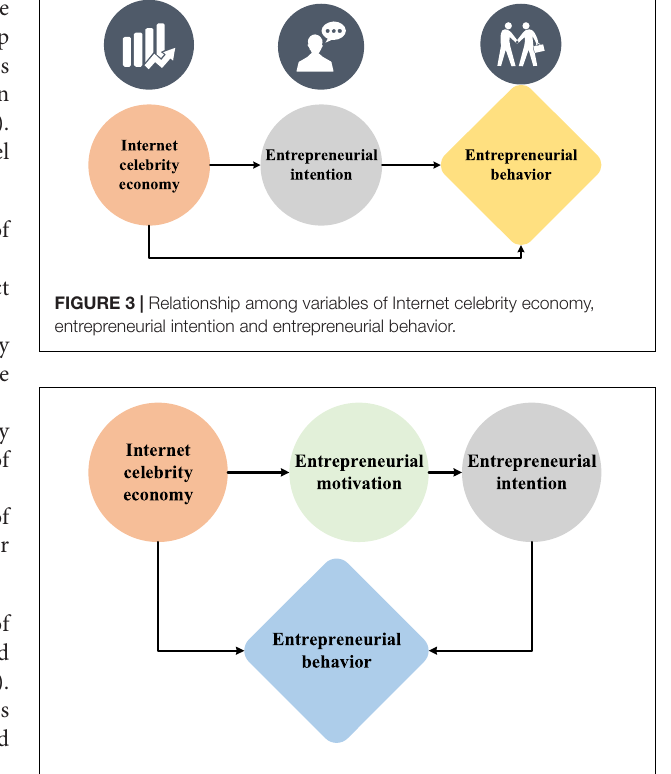
FIGURE 4 | Relationship among variables of the Internet celebrity economy, entrepreneurial intention, entrepreneurial motivation and entrepreneurial behavior.